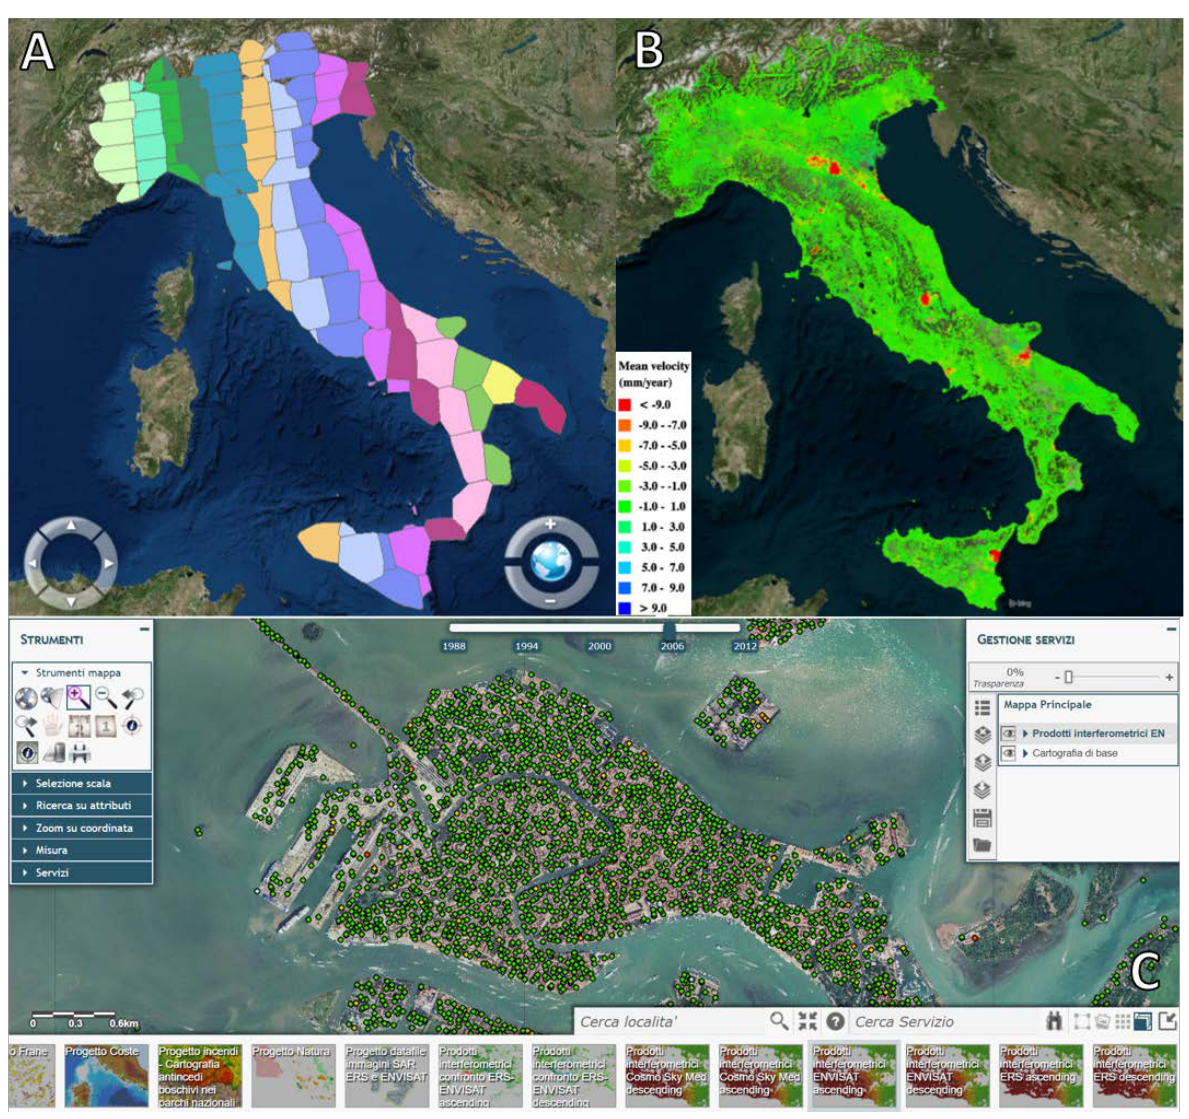
Figure 2: Italian deformation map derived from Envisat ascending data (PST-A project). A) Frames analysed; B) PS data coverage modified after Costantini et al. (2017); C) Snapshot on the city of Venice extracted from the WebGIS platform of the PST-A